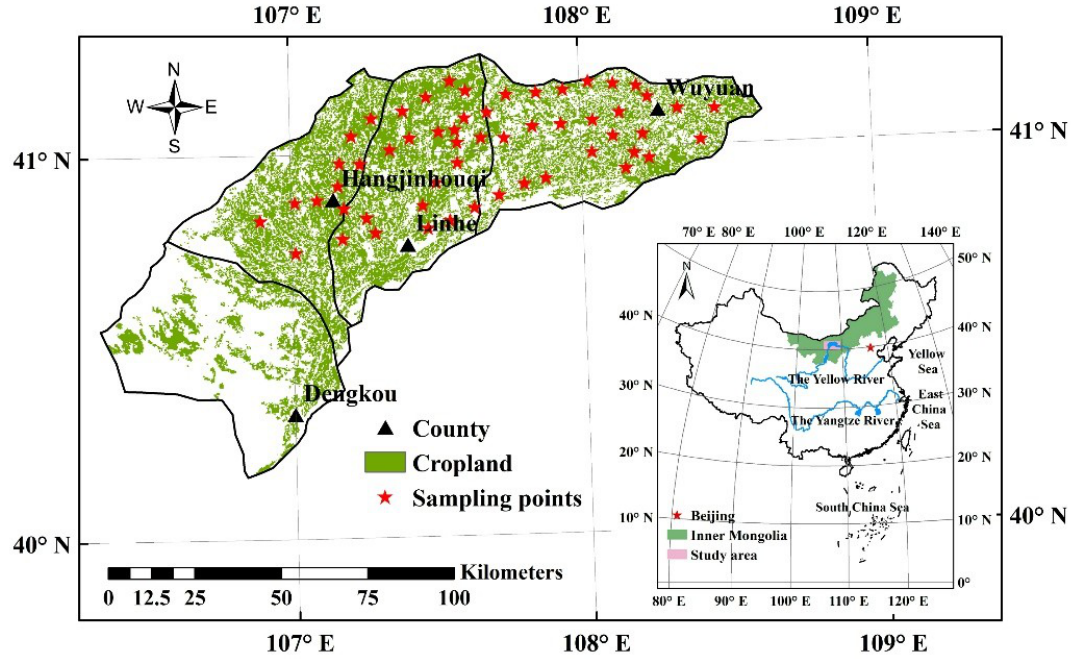
Figure 1. Location and cropland distribution of the study area and sampling points in 2014 and 2015.